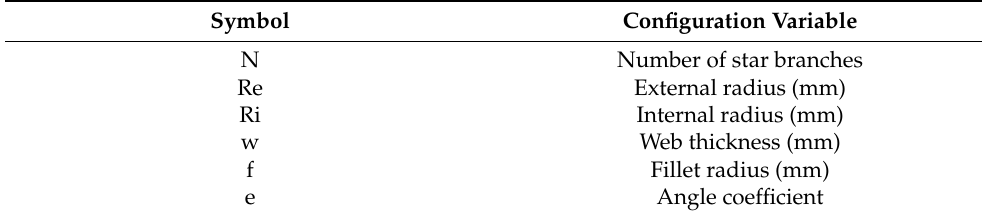
Figure 6. Results analysis ( a ) Class classification criterion and hyperplane ( b ) Comparison of Z and margin ( (cid:1876) (cid:2870) : − 2.9)